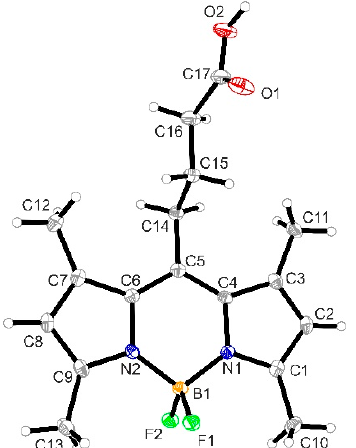
Figure 4. Crystal structure of compound 1 found in the asymmetric unit. Thermals ellipsoids are shown with 50% probability. The CH 2 Cl 2 solvent molecule was omitted for clarity.